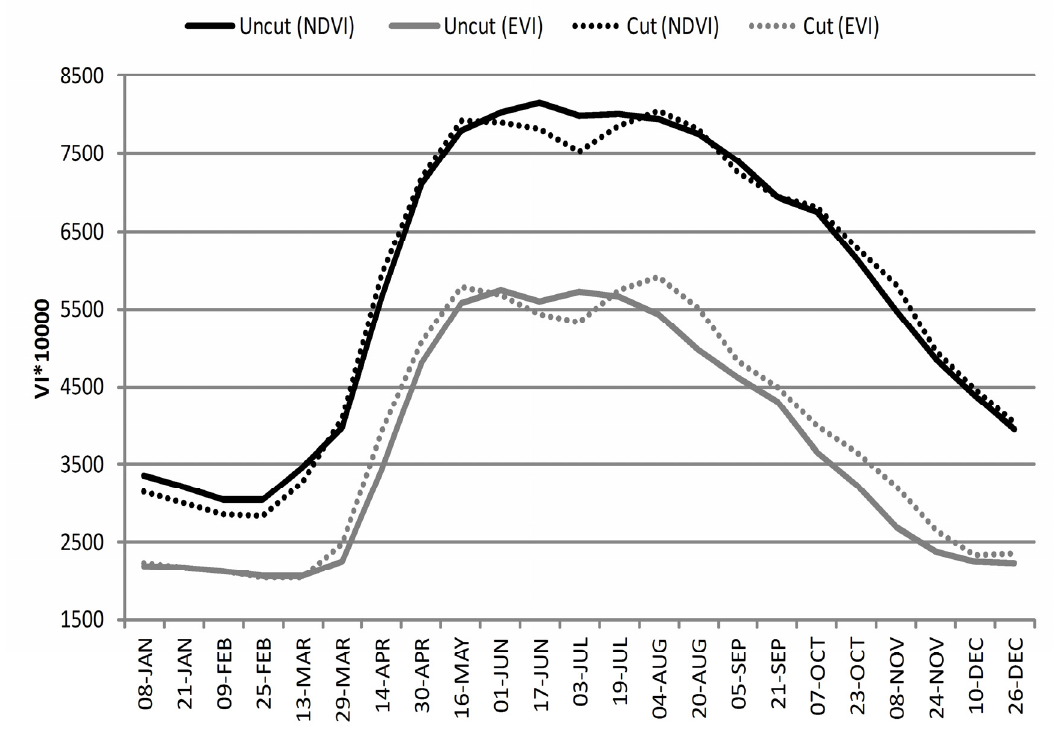
Figure 7. Temporal profile of NDVI and EVI in cut (dot line) and uncut (solid line) hay